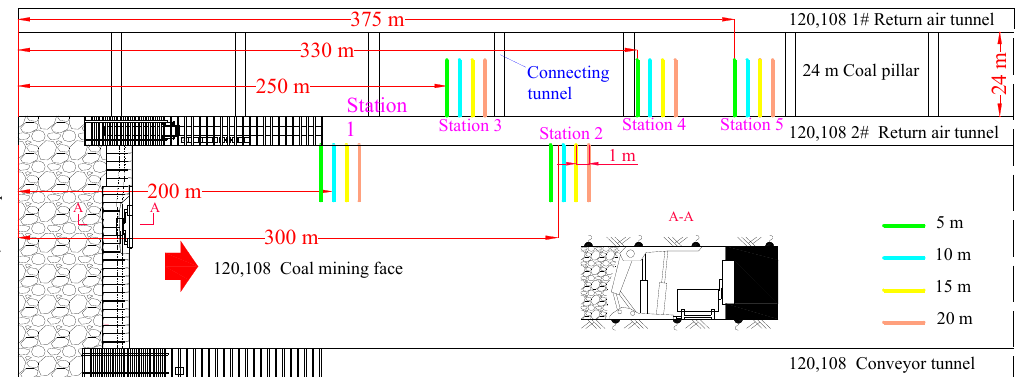
Figure 5. Installation diagram of flexible detection unit.